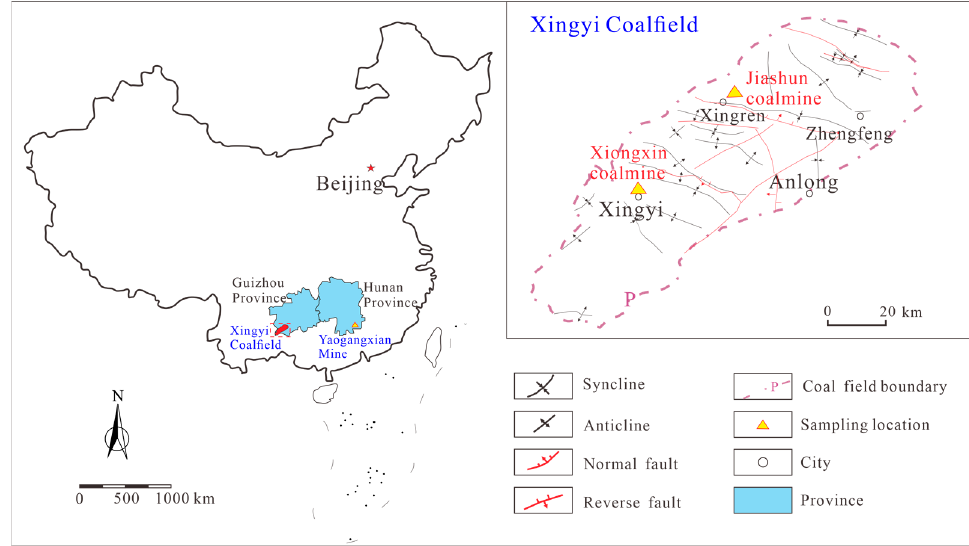
Figure 1. Sampling location of coal-pyrite and mineral-pyrite.